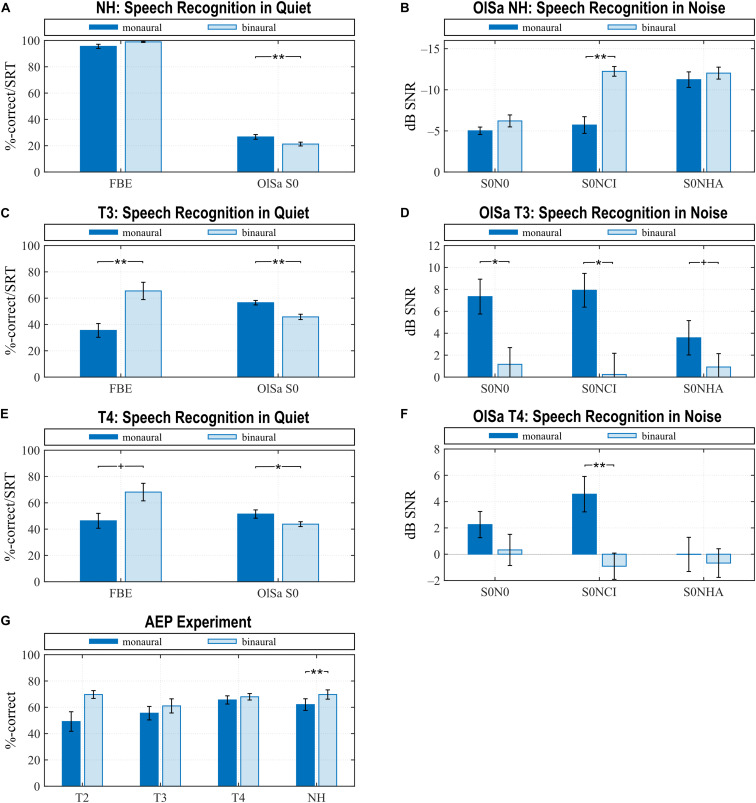
Speech perception with FBE and OlSa tests (A–F) and assessed in the AEP experiment (G). Higher values signal better speech recognition in the FBE and AEP conditions, whereas lower values indicate better speech recognition in OlSa tests. Note the reversed vertical scale in (B). Perception is best in NH listeners (A,B,G), worst shortly after CI provision (C,D,G) and improves with CI experience (E–G). Statistically significant differences between monaural listening with the CI or the designated CI ear in NH and binaural speech recognition was observed for several test conditions. Due to insufficient monaural hearing, monaural data at T2 are only available for the AEP condition, where a significant difference existed between monaural and binaural listening. While behavioral results from the AEP experiment at T3 and T4 did not evidence a significant difference between listening conditions, behavioral tests showed significantly better bimodal speech recognition at T3 for all test conditions and at T4 for the S0NCI condition. Regarding the spatial arrangement of speech and noise sources, the AEP condition is closest to S0NHA. Means and their standard error are shown (**p < 0.01, *p < 0.05, trends +p < 0.1).